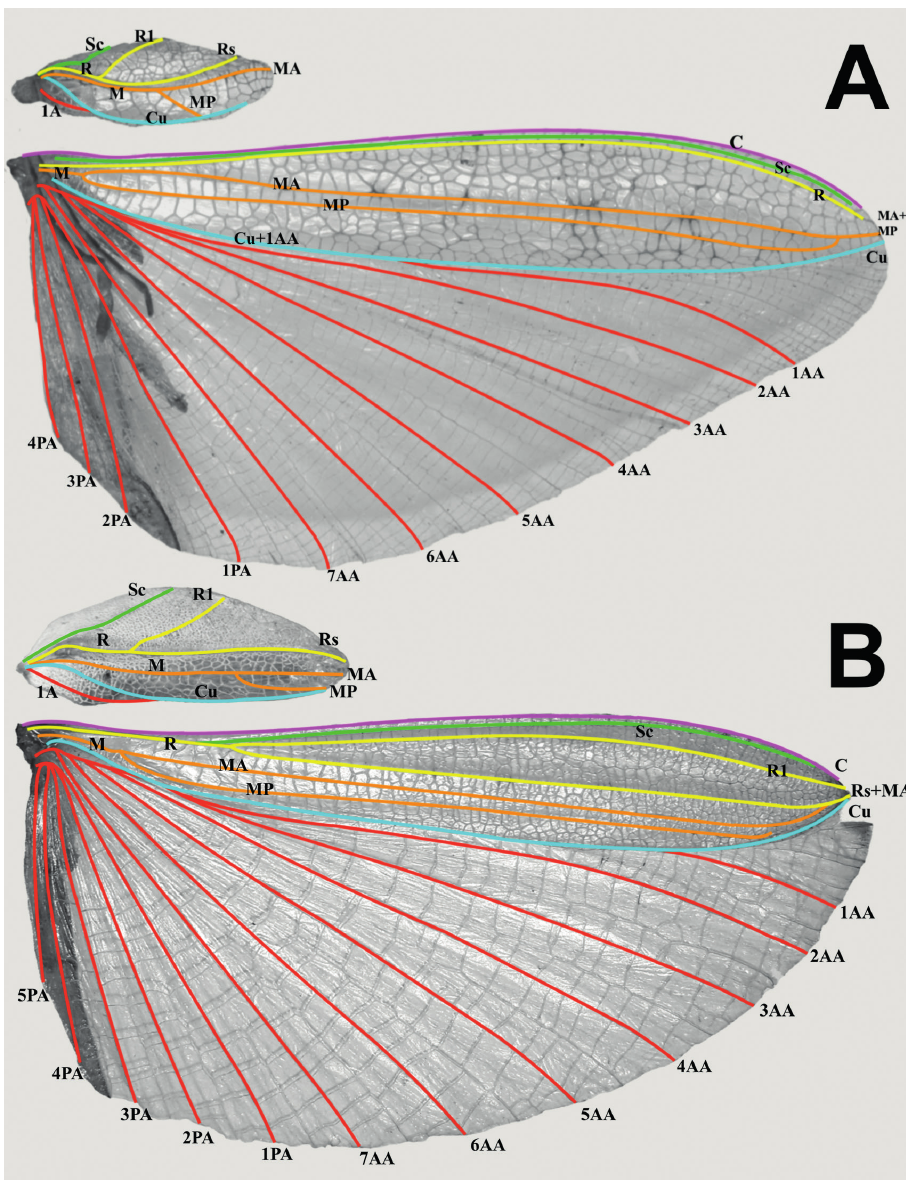
Figure 3. Male tegmina venation for two of the herein described genera A Rakaphyllium schultzei comb. nov. (MNHU) B Vaabonbonphyllium rafidahae (IMQC) (Coll RC 19-106). Abbreviations: Sc (subcosta); R (radius); R1 (radius 1); Rs (radial sector); Rs+MA (fused radial sector and media an- terior); M (media); MA (media anterior); MP (media posterior); Cu+1AA (fused cubitus and first anterior anal); 1AA–7AA (first through seventh anterior anal); 1PA–5PA (first through fifth posterior anal); 1A (first